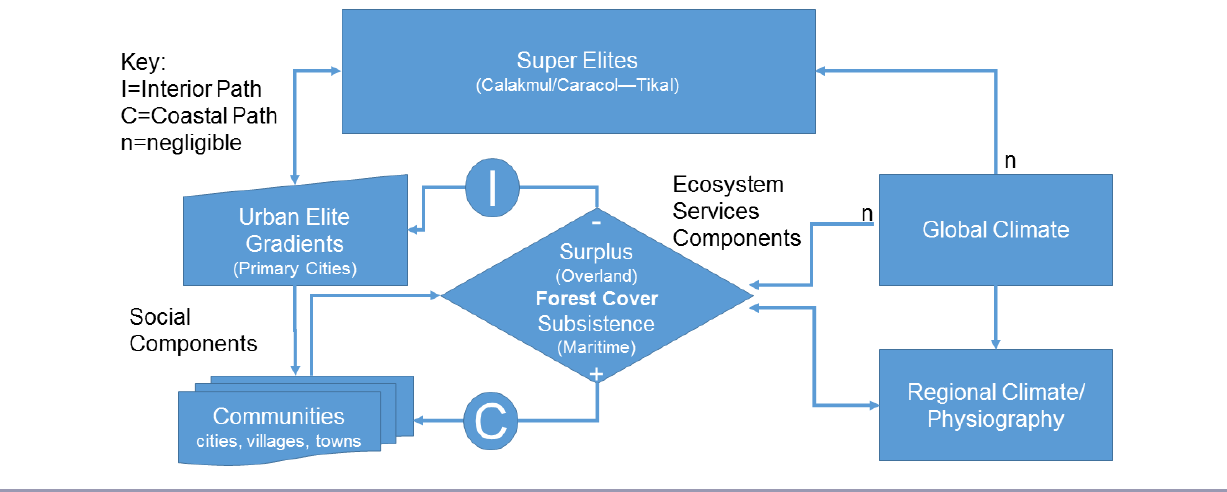
Fig. 6 . Key components of the Maya lowlands complex adaptive